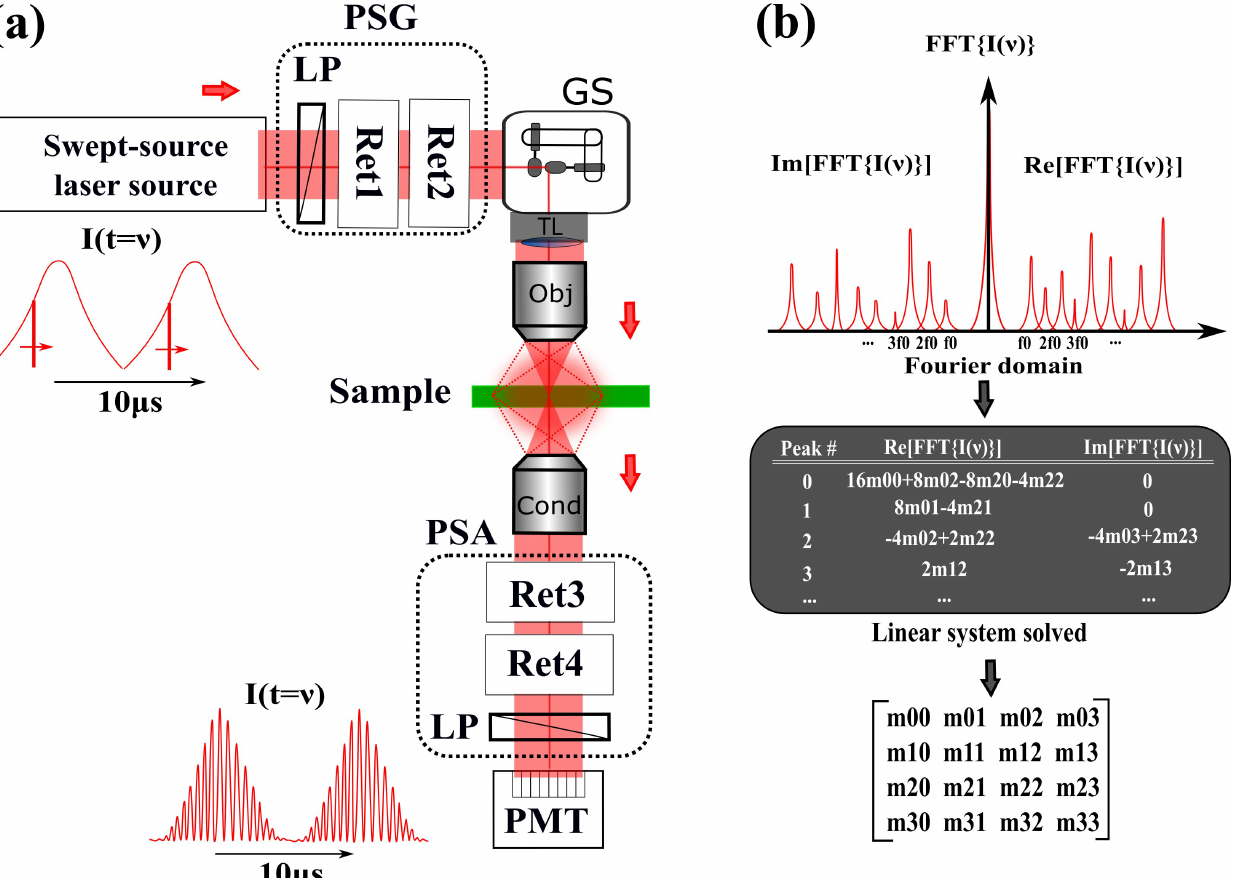
Figure 3. ( a ) Block diagram of a MM SLM based on the spectral encoding/decoding of the polarization states from Reference [31]. ( b ) Schematic presenting the extraction of the MM images of the measured intensities images in the spectral approach. PSG: polarization states generator. PSA: polarization states analyzer. Reti: retarder. Obj: microscope objective. GS: galvanometric scanner. TL: tube lens. S: sample. PMT: photomultiplier